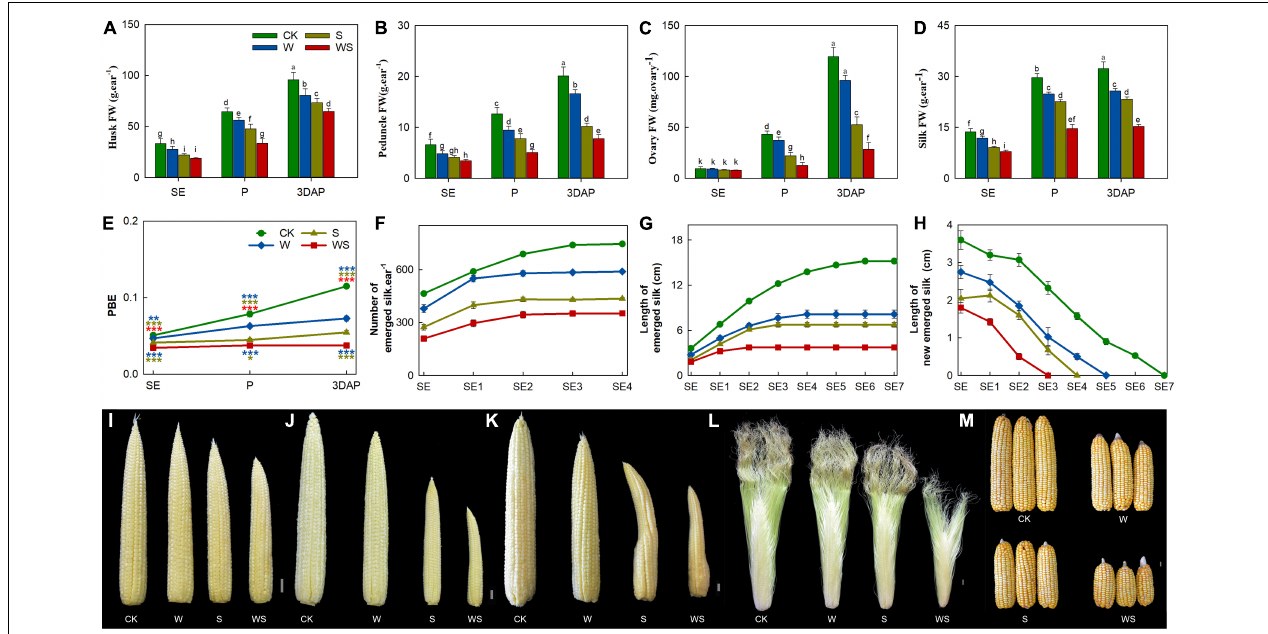
FIGURE 2 | Growth status and phenotype of ear in control (CK), waterlogging + shading (WS), waterlogging (W), and shading (S) treatment groups. Husks fresh weight (FW) (A) , peduncle FW (B) , ovaries FW (from positions 30–45 along the ear rows) (C) , silks FW (D) , proportion of biomass allocation to ear (PBE) (E) , total number of emerged silks every day (F) , length of emerged silk from bract every day (G) , length of newly emerged silk from bract per day (H) . Phenotypes of ears at SE (first silk emergence) (I) , P (full silk emergence) (J,L) , 3DAP (3 days after pollination) (K) and harvest (M) . Data were subjected to one-way ANOVA followed by Duncan’s new multiple range test. Different letters above bars indicate significant differences. Colored asterisks above line chart indicate significant differences between CK and treatment groups, colored asterisks below indicate significant differences between WS and W or S groups. Error bars represent ± SD ( n ≥ 4). * P < 0.05, ** P < 0.01, *** P < 0.001 (ANOVA and t